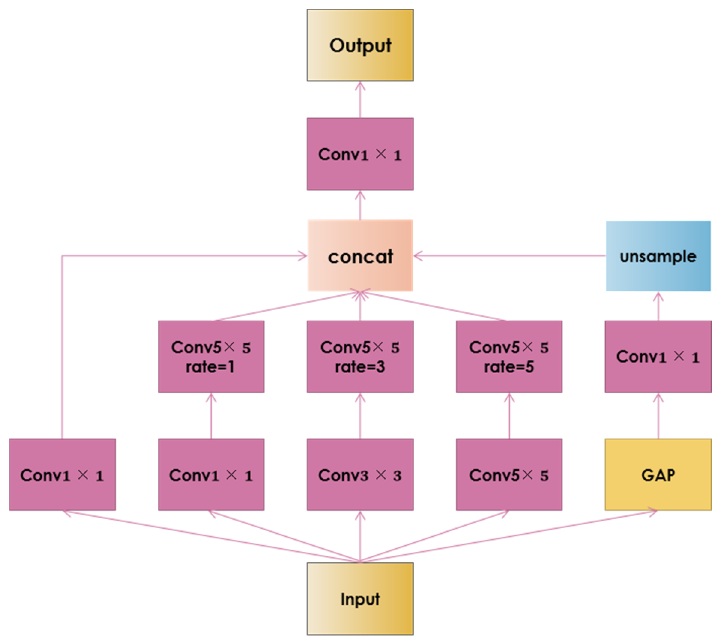
Figure 7. Structure of the RFSPP module. Rate represents the dilated rate and GAP represents the global average pooling.